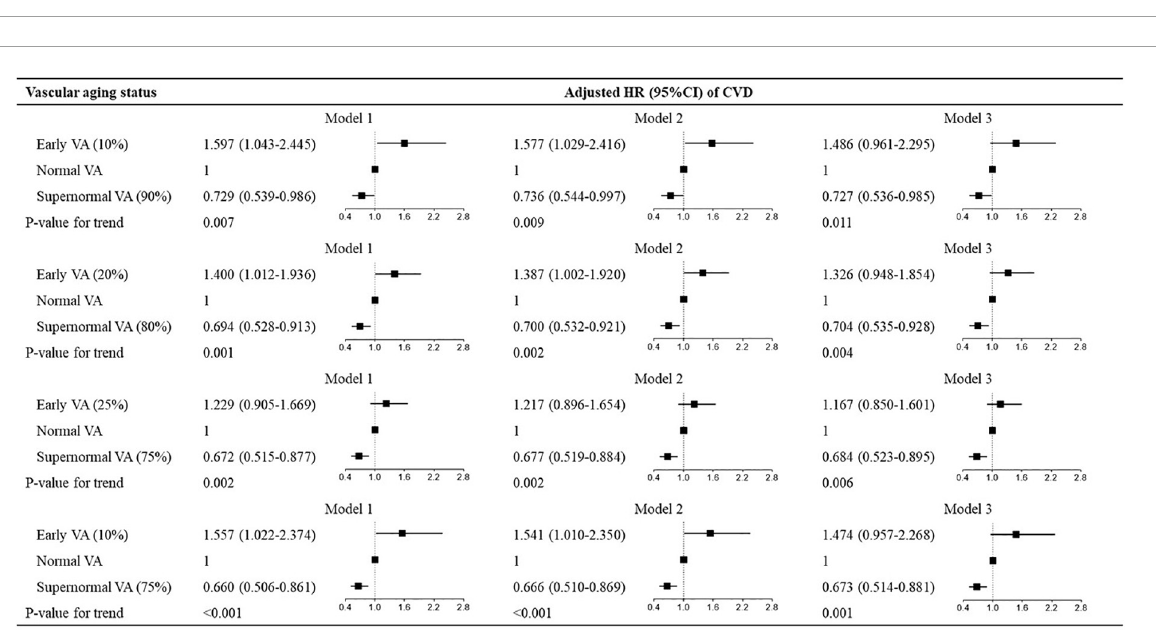
FIGURE3 Hazard ratios for different cutoff values of vascular aging categories for CVD. Hazard ratios for vascular aging categories for CVD. The cutoff values for the three vascular aging categories are, respectively, defined by 10% and 90%, 20% and 80%, 25% and 75%, and 10% and 75% percentiles of (cid:49) -age. Model 1: adjusted for age and sex; model 2: model 1 + Framingham risk score; model 3: model 1 + ASCVD risk score. VA, vascular aging; CVD, cardiovascular disease; ASCVD, atherosclerotic cardiovascular disease; HR, hazard ratio; CI, confidence